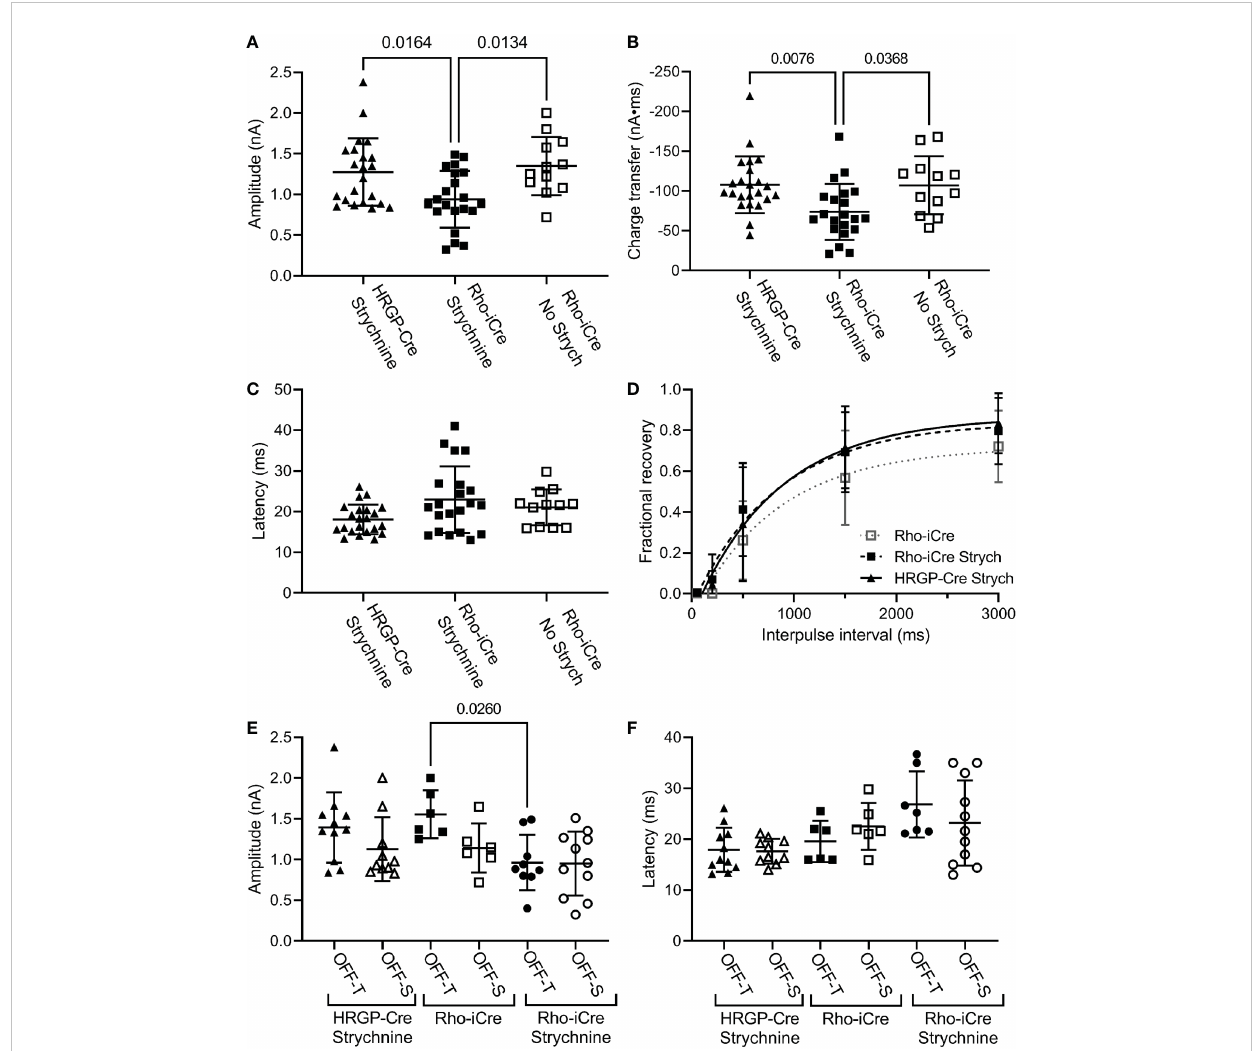
FIGURE 4 Comparison of rod and cone-driven optogenetic responses of OFF a RGCs. (A) Amplitude of currents evoked by optogenetic stimulation of rods was reduced signi fi cantly by the presence of strychnine (1 m M). (Rho-iCre with strychnine, n=21 cells, 9 mice; Rho-iCre without strychnine, n=12 cells, 5 mice; HRGP-Cre with strychnine, n=22 cells, 8 mice). (B) Charge transfer of c evoked by optogenetic stimulation of rods was also reduced signi fi cantly by the presence of strychnine. (C) Latency of rod-driven optogenetic currents was increased by an average of 4.8 ms compared to cone-driven optogenetic currents. (D) Recovery from paired pulse depression was similar for rod-driven optogenetic currents with ( t = 685 ms; df=94) and without strychnine ( t = 781 ms; df=57) and for cone-driven currents with strychnine ( t =852 ms, df=124). (E) Optogenetically-evoked current amplitude did not differ signi fi cantly between OFF-transient and OFF-sustained cells in both rod- and cone-driven cells. Strychnine reduced the amplitude of rod-driven currents in OFF transient cells signi fi cantly (Rho-iCre transient and sustained RGCs without strychnine, n=6 cells